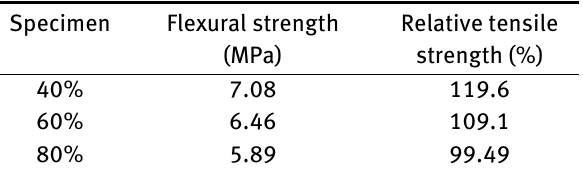
Table 25: Absorption of geopolymer mortar reinforced with 1% steel